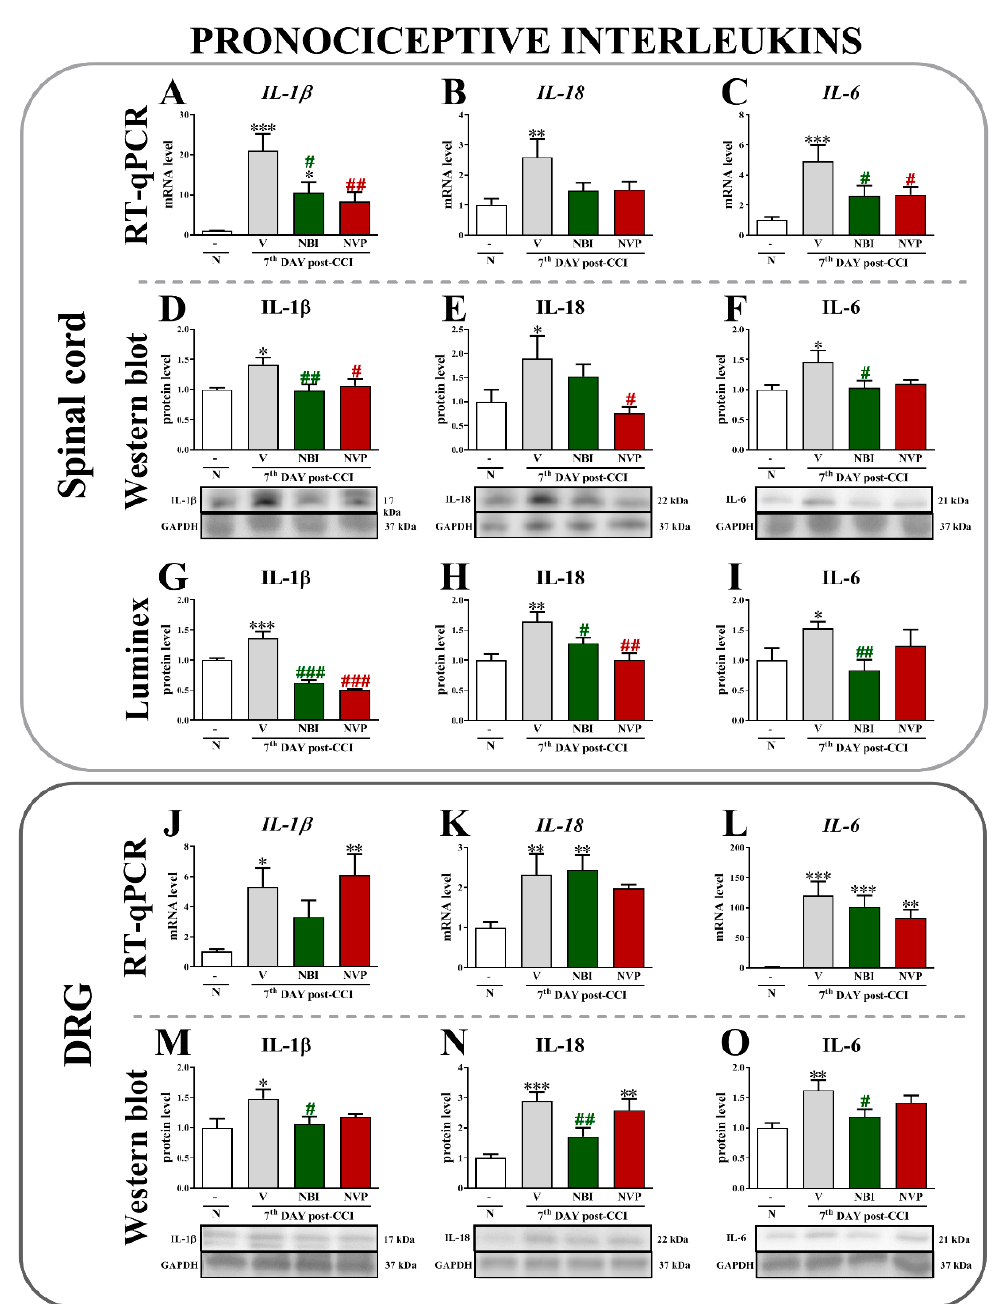
Figure 3. Comparison of the effects of repeated intrathecal ( i.t .) administration of ( ± )-NBI 74330 and NVP CXCR2 20 (10 µg/5 µL; each) on the mRNA ( A – C , J – L ) and protein ( D – I , M – O ) levels of select interleukins (IL-1 β , IL-18, and IL-6) in the spinal cord ( A – I ) and DRG ( J – O ) on the 7th day after chronic constriction injury in rats. The RT-qPCR, Western blot, and Luminex data are presented as the means ± SEM (4–10 rats per group for RT-qPCR and 4–7 for Western blot or Luminex assays). The results were evaluated using one-way ANOVA followed by Bonferroni’s test. * p < 0.05, ** p < 0.01, and *** p < 0.001 for the comparison of naive animals with all groups. # p < 0.05, ## p < 0.01, and ### p < 0.001 for the comparison of vehicle-treated animals with all groups. Abbreviations: naive, N; vehicle, V; ( ± )-NBI 74330, NBI; NVP CXCR2 20,